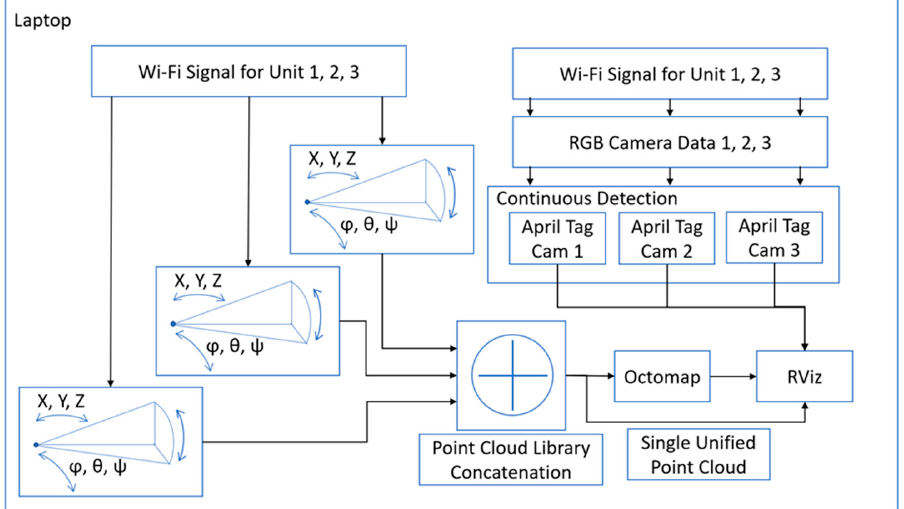
Figure 6. Base System—Laptop Block Diagram.